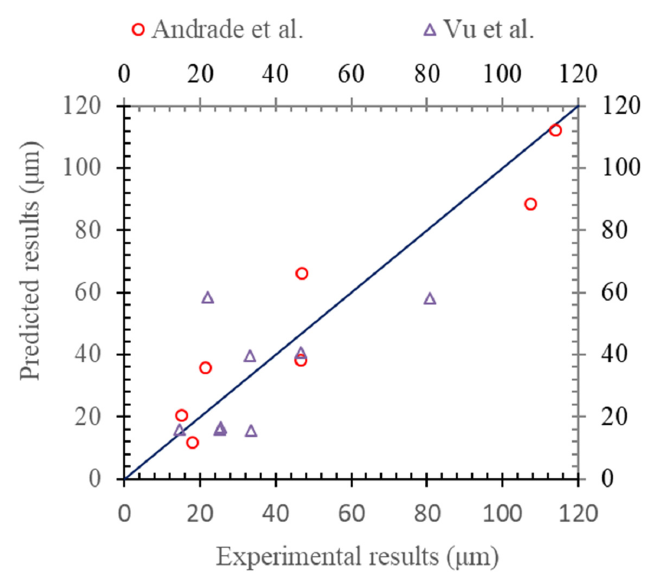
Figure 7. Radial loss corresponding to surface cracking (Melchers’ model).